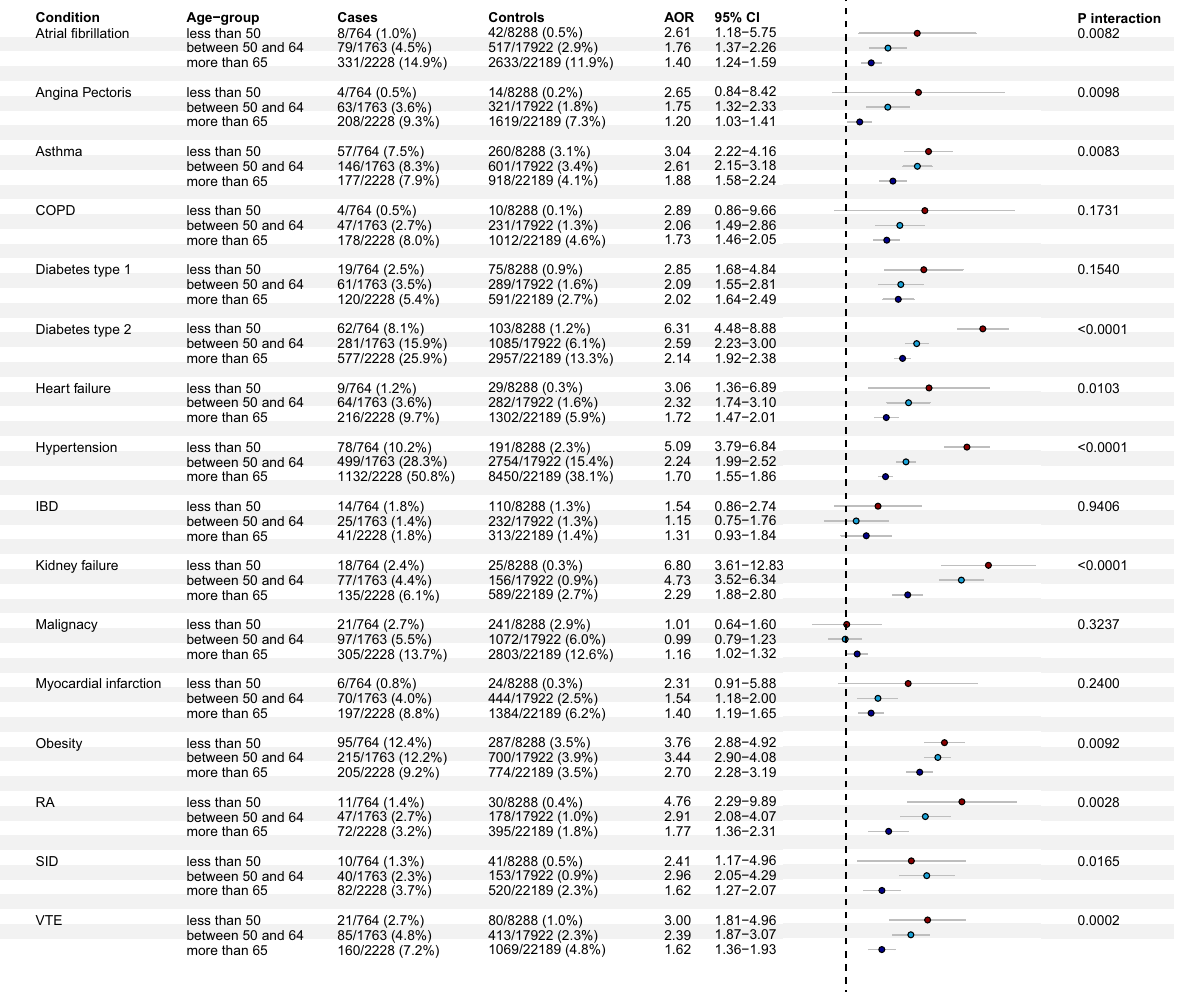
Fig. 1 Associations of pre-existing co-morbidities and severe COVID-19 (adjusted ORs with 95% CIs and p-value for age interaction) in all three age groups. This fully adjusted model included co-variates of age, sex, sociodemographic and socioeconomic variables (marital status, region of birth, disposable income, and educational level) for all